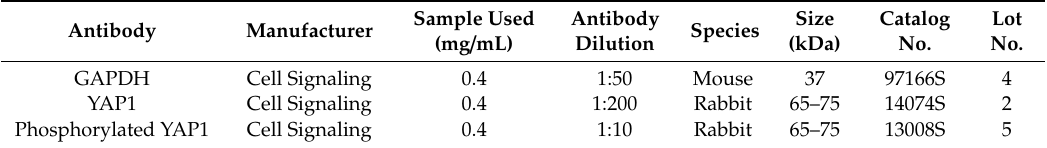
Table 2. Antibodies Used for Western Blotting.